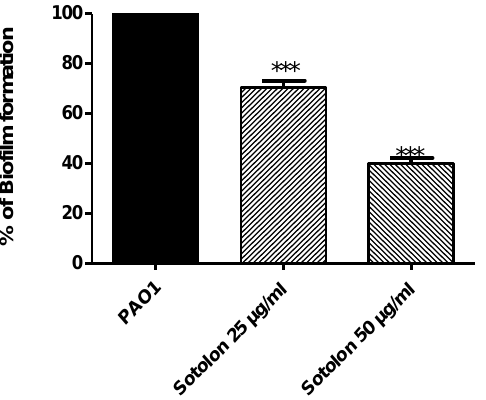
Figure 1. Inhibition of biofilm production of PAO1 strain by sotolon. PAO1 cultures were prepared with and without Sotolon sub-MIC (1/4 and 1/8 MIC). One-way ANOVA test (Graphpad Prism 8 software) was employed to compare between the results of sotolon sub-MIC treated and untreated PAO1 cultures. The results were assumed statistically significant when p values < 0.05. The data obtained were presented as mean ± standard error of percentage change from untreated cultures. Sotolon in 1/4 and 1/8 MIC significantly reduced the biofilm formation ( p < 0.0001). *** = p < 0.001.